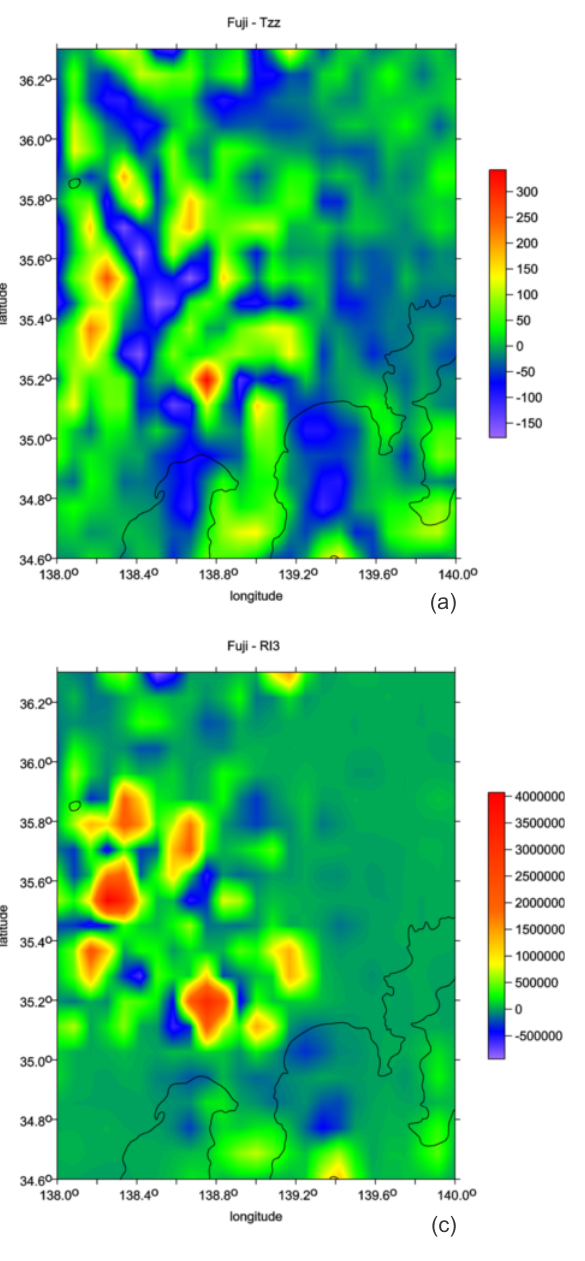
- note the large scale (more than 300 E); (b,c) the zz